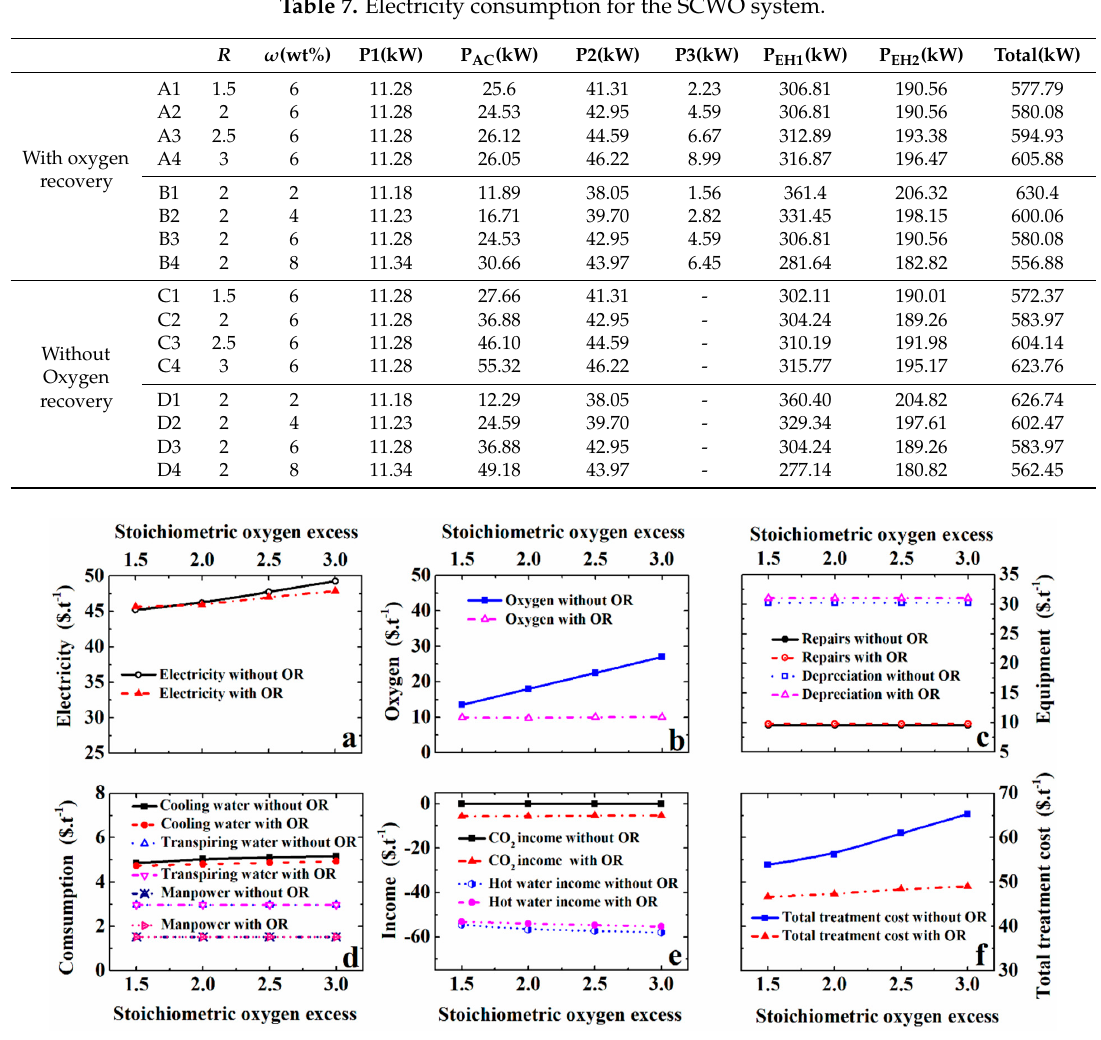
Figure 11. The effect of R on the treatment cost for the SCWO system with and without OR, ( a